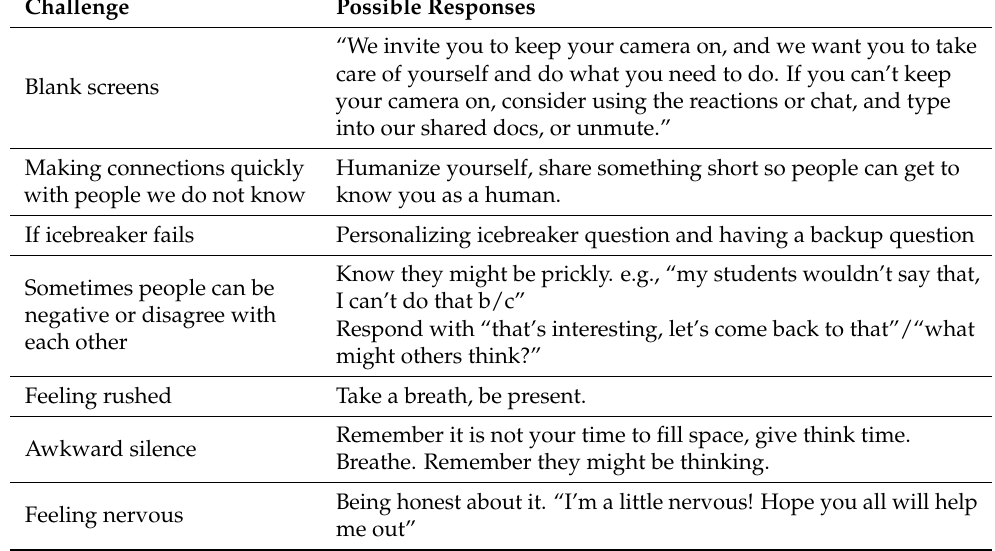
Table 4. Facilitator moves for session with